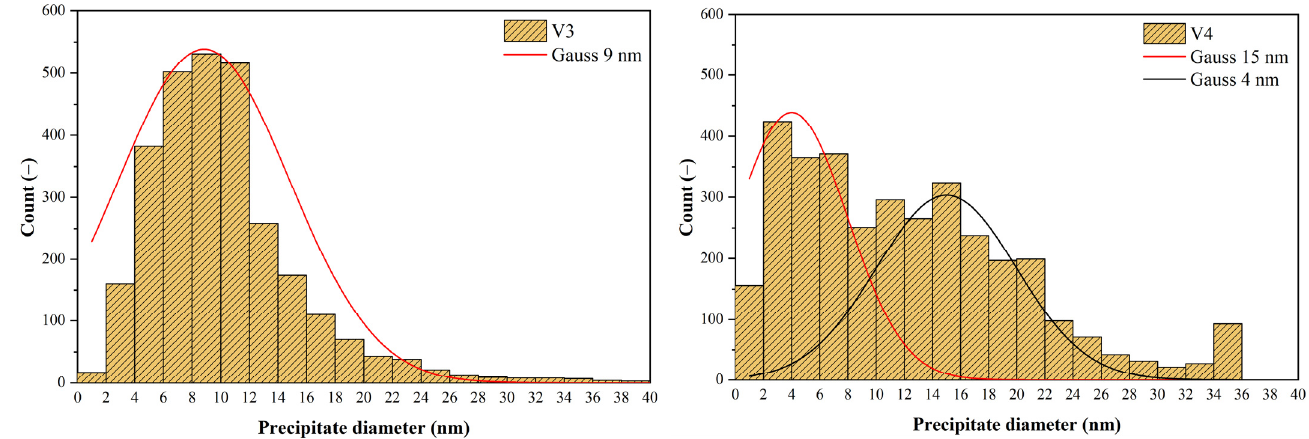
Figure 23. Histograms showing the distribution of precipitates below 40 nm in the samples for V3 ( left ) and V4 ( right ). ( left ) and V4 ( right